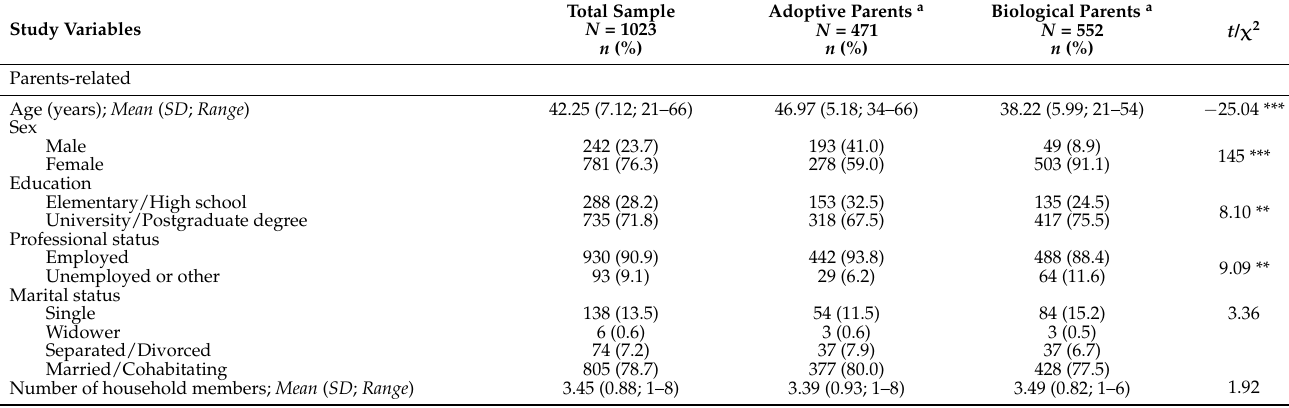
Table 1. Sample Characteristics of Study 1, According to Family Type (Adoptive vs. Biological Parents): Descriptive Statistics and Group